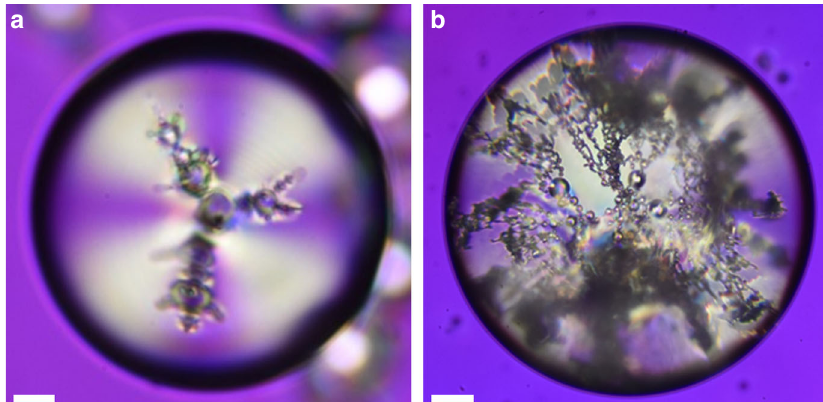
Fig. 8 Large scale, complex fractal satellite packing. Polarizing optical microscopy photographs of a a nematic droplet with a fractal colloidal structure (tetrahedral frame with another arm behind the focal plane) and b a nematic droplet (450 μ m radius) with an incoherent cascade of fractal structures formed by water inclusions with normal boundary conditions. A full waveplate is inserted at 45° to the crossed polarizers to see the 3D structure clearly. Retardation difference from the waveplate is screened by the high retardation due to the thickness of the nematic droplet. Scale bar a: 10 μ m, scale bar b : 100